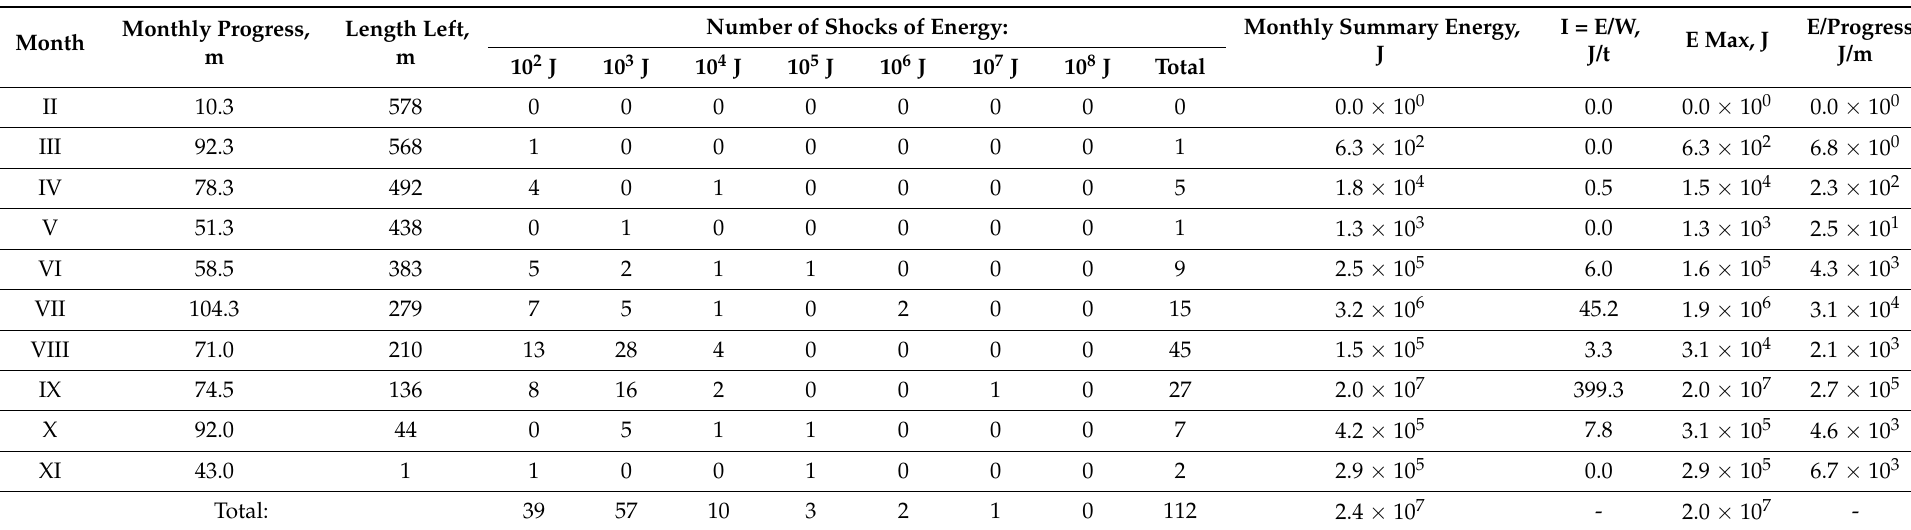
Table 1. Shocks registered during the exploitation of seam 713/1-2 at longwall